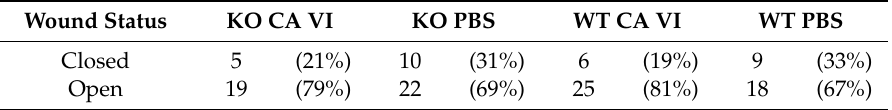
Figure 3. The microscopic analysis of the wounds. ( A ) The length of newly formed epithelium (black) and epithelial gap (gray). ( B ) The area of granulation tissue. Error bars represent SEM, n = 6 CA VI KO, n = 7 wild-type (WT) phosphate-buffered saline (PBS), n = 8 others. No statistically significant differences were found by analysis of variance. Table 2. The number of closed (complete re-epithelialization) and open wounds on day 7 based on histological analysis. n = 7 CA VI KO, n = 8 others. No statistically significant differences in chi-squared analysis.